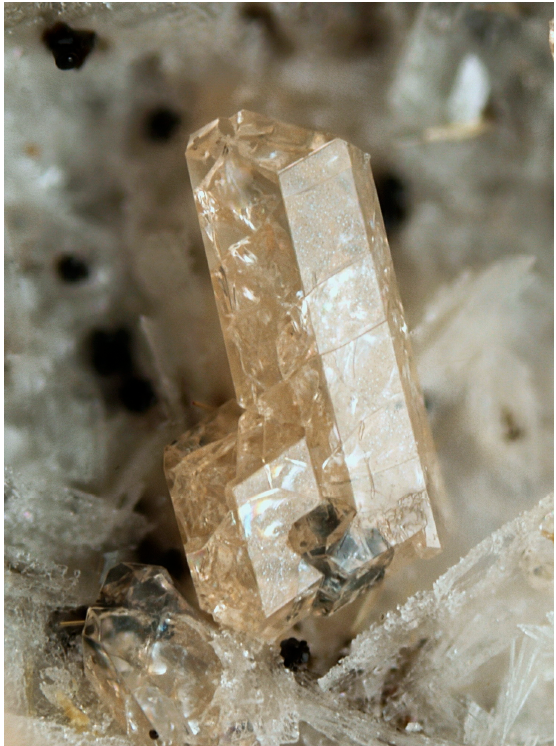
Figure 4. Twin of a F-rich sodalite-group mineral on sanidinite. Sample 9. Photographer: Marko Burkhardt. Field width: 1 mm.